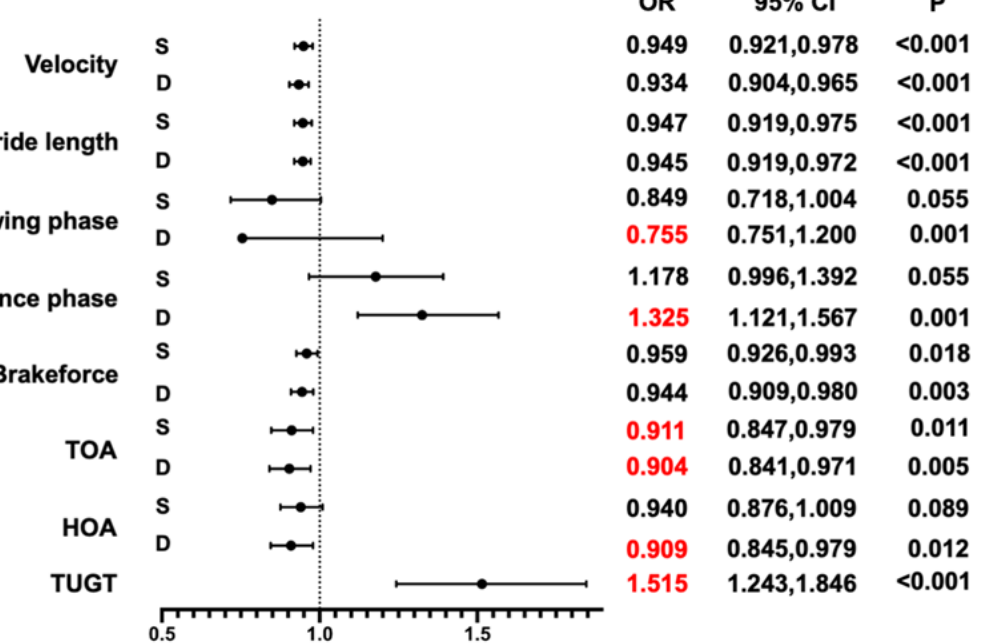
Figure 1. Forest map of multivariate logistic regression analysis for the association between gait indicators and a risk of cognitive impairment, where red represents significant associations both in dual- and single-task. Abbreviations: OR, odds ratio; CI, confidence interval. S, single-task; D, dual-tasks; TOA, toe-off ground angle; HOA, heel-to-ground angle; TUGT, timed “Up & Go” time.